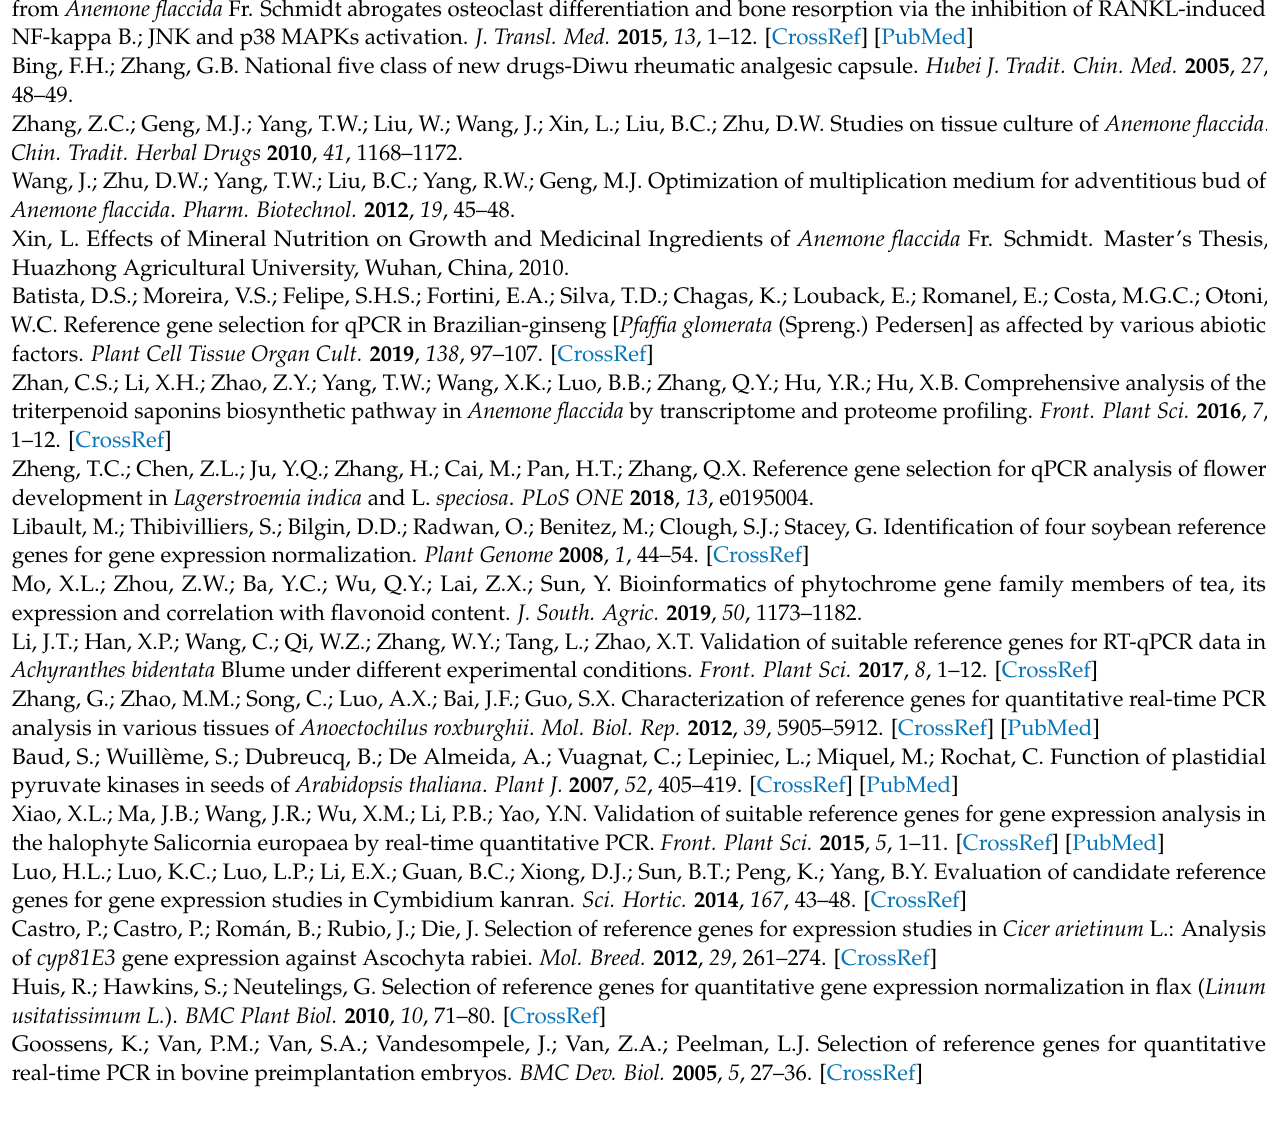
cation fragments were separated by 2% agarose gel electrophoresis. Figure S3: Melting curves of RT-qPCR amplifications of 10 candidate reference genes. Figure S4: Amplification efficiency of 10 candidate reference genes. Table S1: Expression stability ranking of 10 candidate reference genes by using geNorm (G), NormFinder (N) and BestKeeper (B)